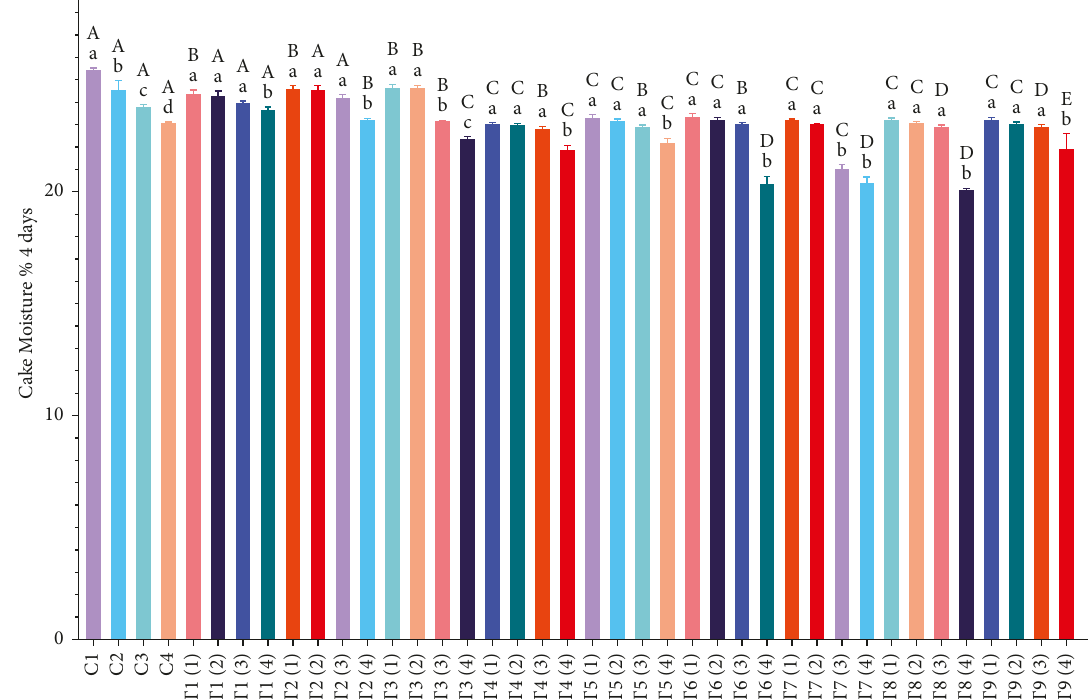
Figure 1: Moisture content of cake samples were measured through general methods of AOAC by electric oven, using weight loss before and after heating of 2 grams of the samples at 103 2 ° C to reach a constant weight. The data are expressed as mean SD from at least three separate experiments. Inter-group comparisons were made using one way ANOVA.The different lowercase letters indicate significant changes of a treatment’s moisture during the four-day period at p 0 . 05 probability level. Different capital letters indicate the significant ± ± difference between treatments’ moisture in the same day compared to each other at p 0 . 05 probability < <